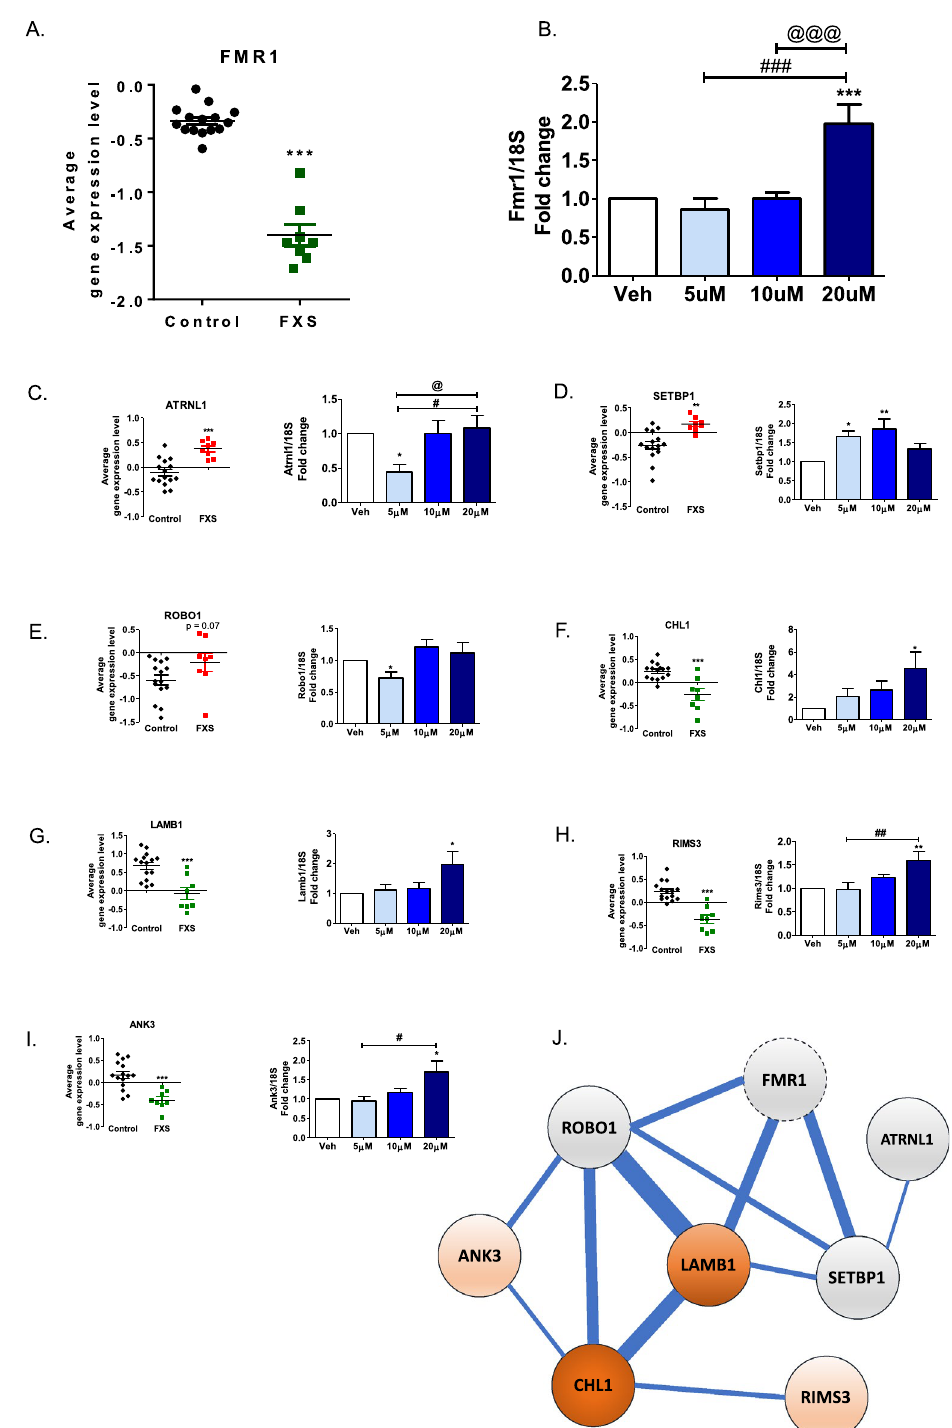
Figure 2. Upregulation of Fmr1 gene expression upon pirenperone treatment ( A ) FMR1 gene expression was significantly down- regulated in human FXS patients. Unpaired t-test. Control versus FXS, *** p < 0.001 ( B ) Fmr1 gene expression level was significantly up-regulated after pirenperone treatment at a dose of 20 μM in cortical neuron. ( C ) Gene expression level for ATRNL1 in human patients (left) and real-time PCR result in cultures (right). ( D ) Gene expression level for SETBP1 in human patients (left) and real-time PCR result in cultures (right). ( E ) Gene expression level for ROBO11 in human patients (left) and real-time PCR result in cultures (right). ( F ) Gene expression level for CHL1 in human patients (left) and real-time PCR result in cultures (right). ( G ) Gene expression level for LAMB1 in human patients (left) and real-time PCR result in cultures (right). ( H ) Gene expression level for RIMS3 in human patients (left) and real-time PCR result in cultures (right). ( I ) Gene expression level for ANK3 in human patients (left) and real-time PCR result in cultures (right). One-way ANOVA, post hoc test: Bonferroni’s multiple comparison test, Vehicle versus 20 μM, ***5 μM versus 20 μM, ### 10 μM versus 20 μM, @@@ p < 0.001, number of samples per group = 12. ( J ) Gene expression change after treatment of pirenperone. Color in the circle represents expression difference between the pirenperone and vehicle treatment (red: higher expression in pirenperone, grey means no difference). The thickness of edges represents the number of supporting evidence of a co-expressional relationship between